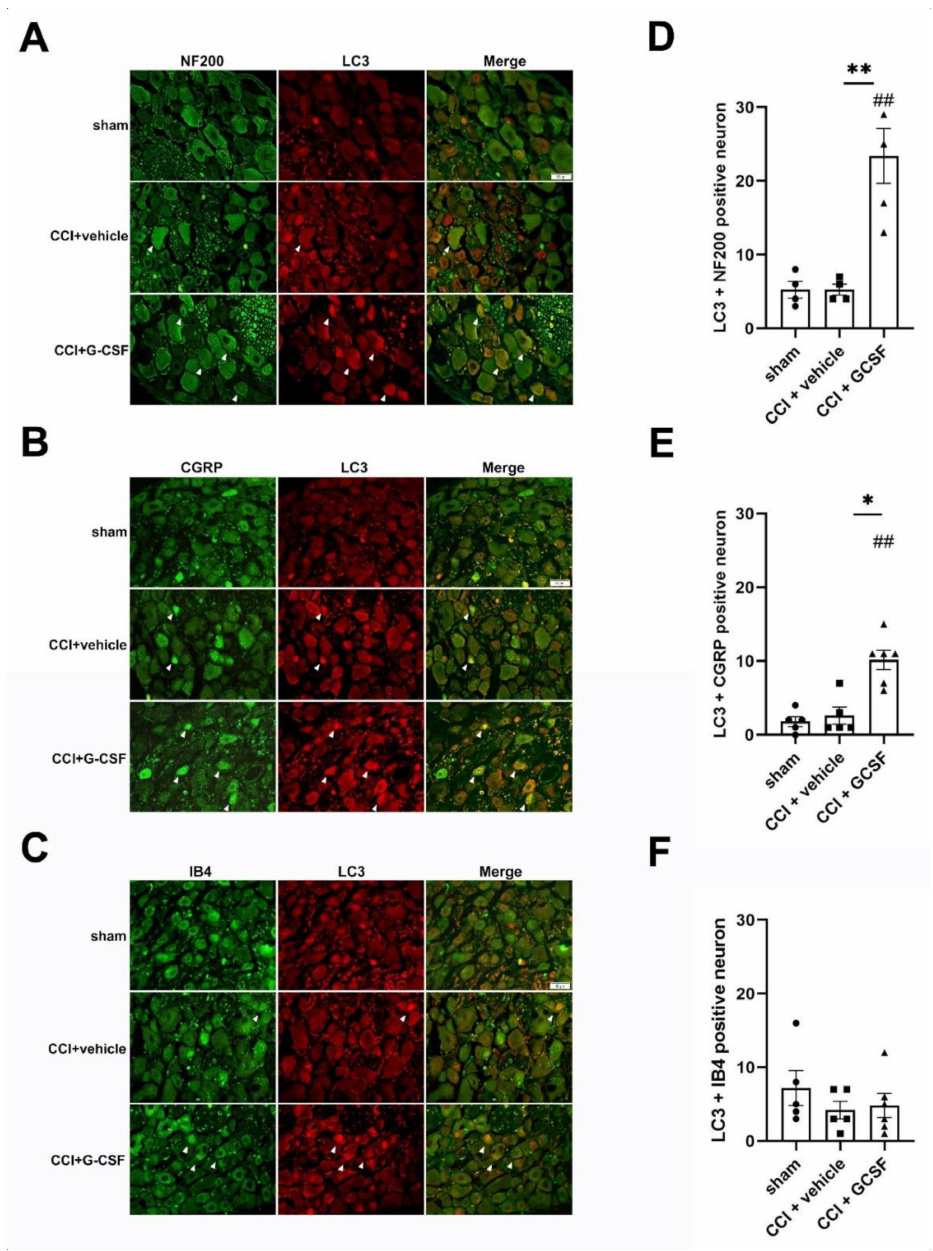
Figure 4. G-CSF upregulated LC3 protein levels in dorsal root ganglia neurons on the 1st day after nerve injury. ( A – C ) Representative images showing LC3 + NF200-, LC3 + CGRP-, and LC3 + IB4-positive DRG neurons (white arrowhead) in sham control rats, vehicle-treated CCI rats, and G-CSF-treated CCI rats on the 1st day after nerve injury. ( D – F ) Significantly higher numbers of neurons positive for LC3 + NF200 and LC3+ CGRP were observed in G-CSF-treated CCI rats than in vehicle-treated CCI rats and sham control rats (** p < 0.01, * p < 0.05: the G-CSF-treated CCI group compared to the vehicle-treated CCI group; ## p < 0.01: the G-CSF-treated CCI group compared to the sham controls). However, there was no significant difference in the numbers of neurons that were positive for LC3 + NF200 and LC3 + CGRP between vehicle-treated CCI rats and sham control rats. There were also no significant differences in the numbers of LC3 + IB4-positive neurons between G-CSF-treated CCI rats, vehicle-treated CCI rats, and sham control rats. Scale bars = 50 µ m. The data are shown as the means ± SEM. n = 5 in each